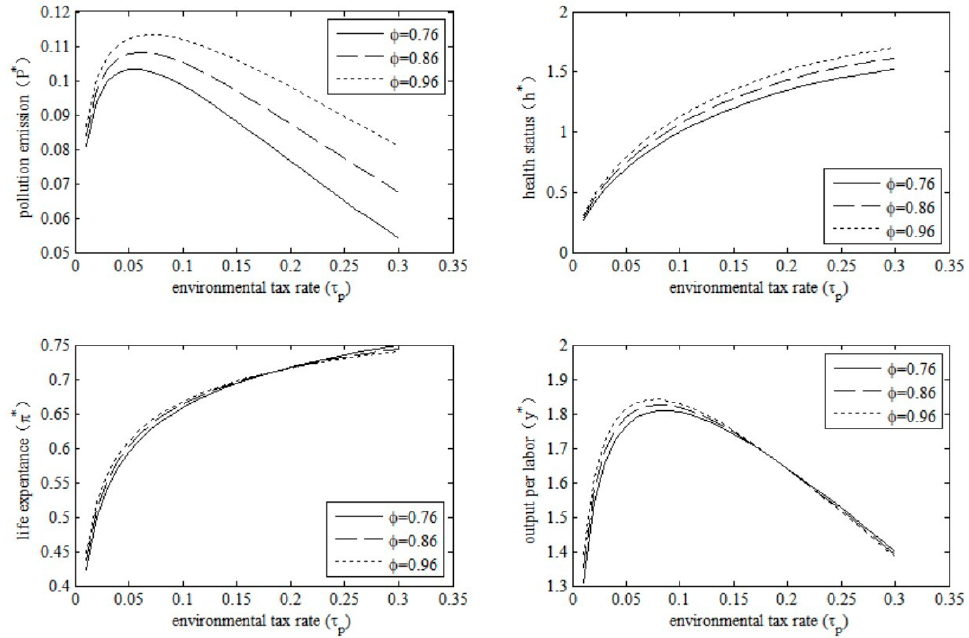
Figure 7. Policy effects of the environmental tax rate.